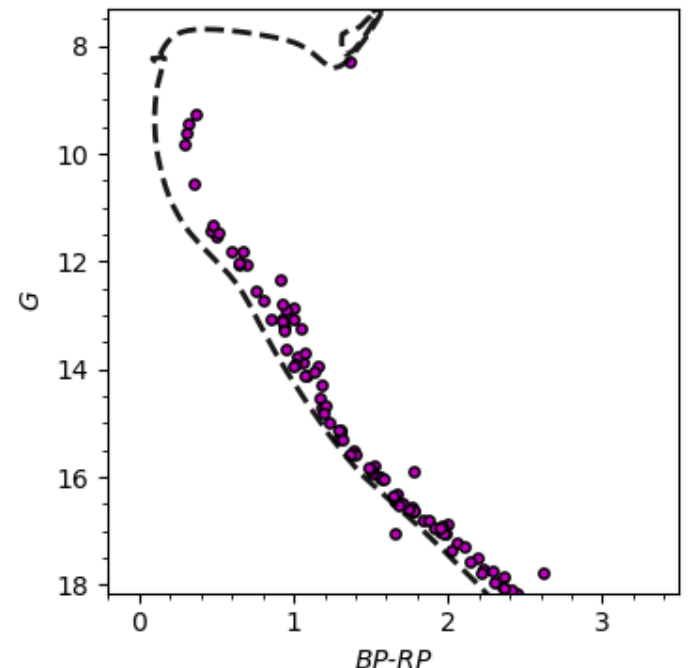
Figure 3. CMD and isochrone fitting of our list of probable members of Theia 847, obtained using Gaia EDR3. The constraints are defined in Table 1.